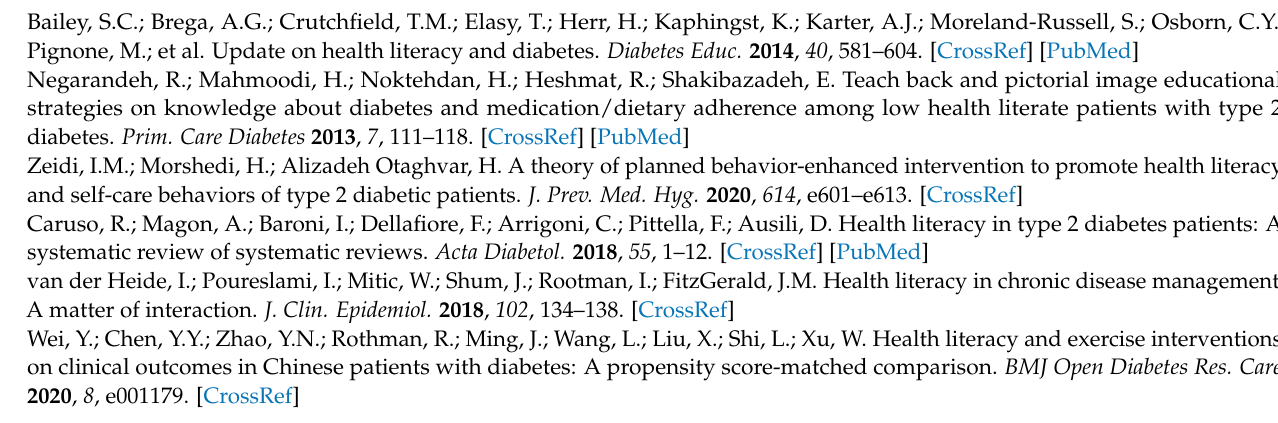
Search strategy; Table S3: General characteristics of included studies; Table S4: Quality assessment of included studies; Table S5: Contents of health literacy assessment tools; Table S6: GRADE summary of findings; Table S7: Sensitivity analysis of included